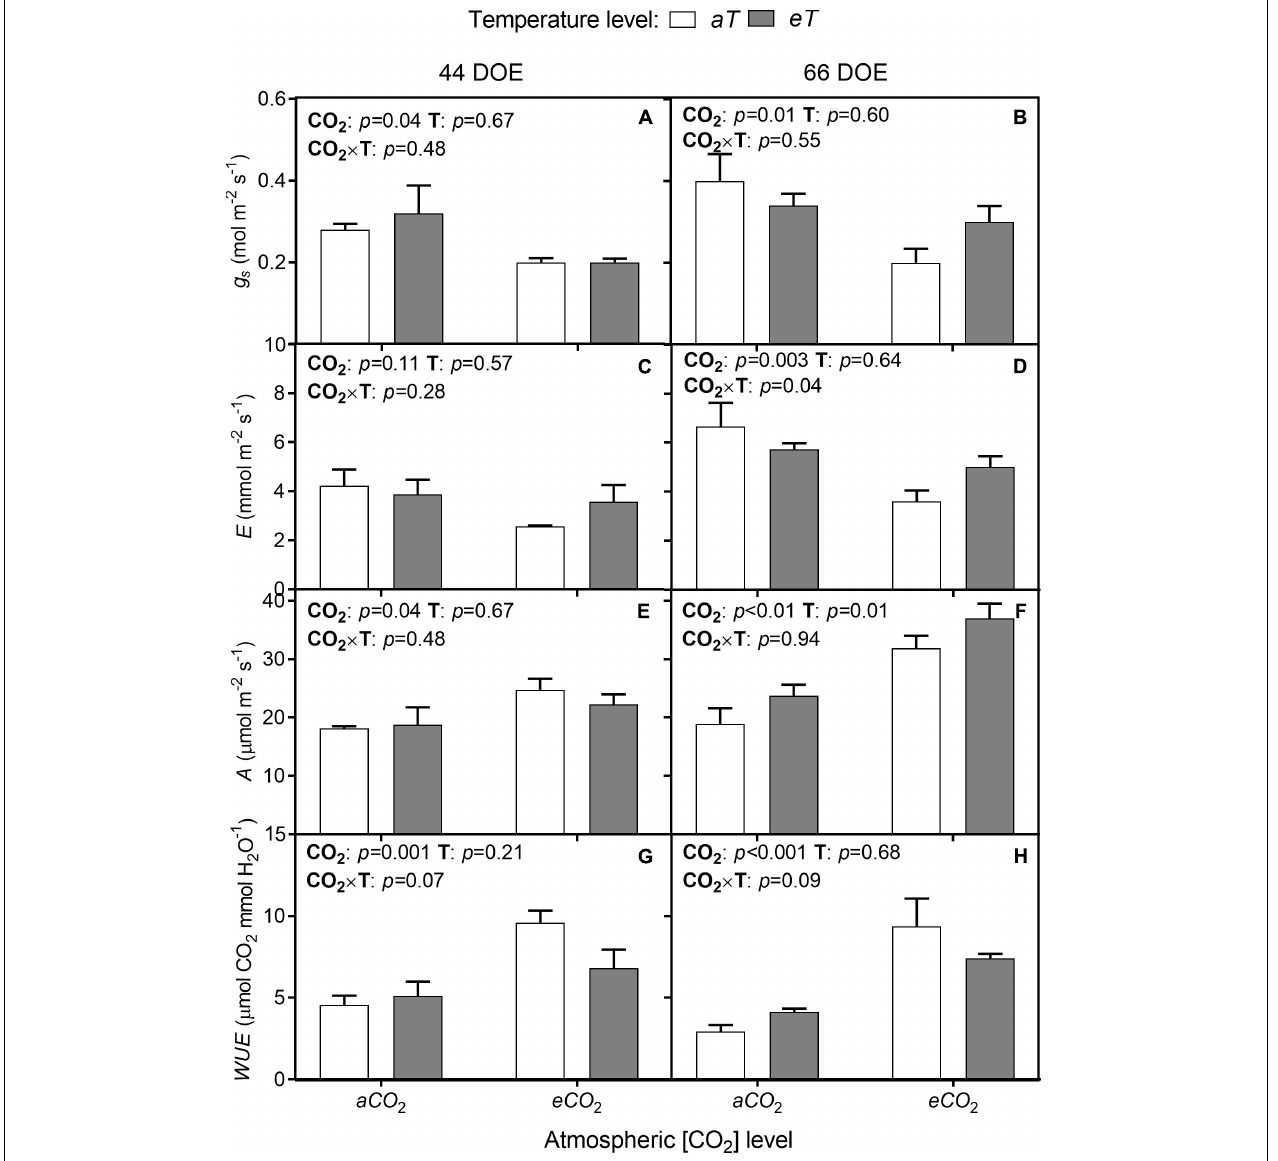
FIGURE 5 | Leaf gas exchange of S. capitata performed at 44th (left column) and 66th DOE (right column) under different levels of [CO 2 ] and temperature. (A,B) Stomatal conductance ( g s ). (C,D) Transpiration rate (E) . (E,F) Net photosynthesis rate (A) . (G,H) Instantaneous water-use efficiency ( WUE ). [CO 2 ] levels: ambient ( aCO 2 ) and elevated ( eCO 2 , 600 µ mol mol − 1 ). Temperature levels: ambient ( aT ) and elevated ( eT , +2 ◦ C above ambient canopy temperature). DOE = day of experiment. ANOVA p -values are shown for main effects (CO 2 or T) or interactions CO 2 × T. Stack bars indicate the standard